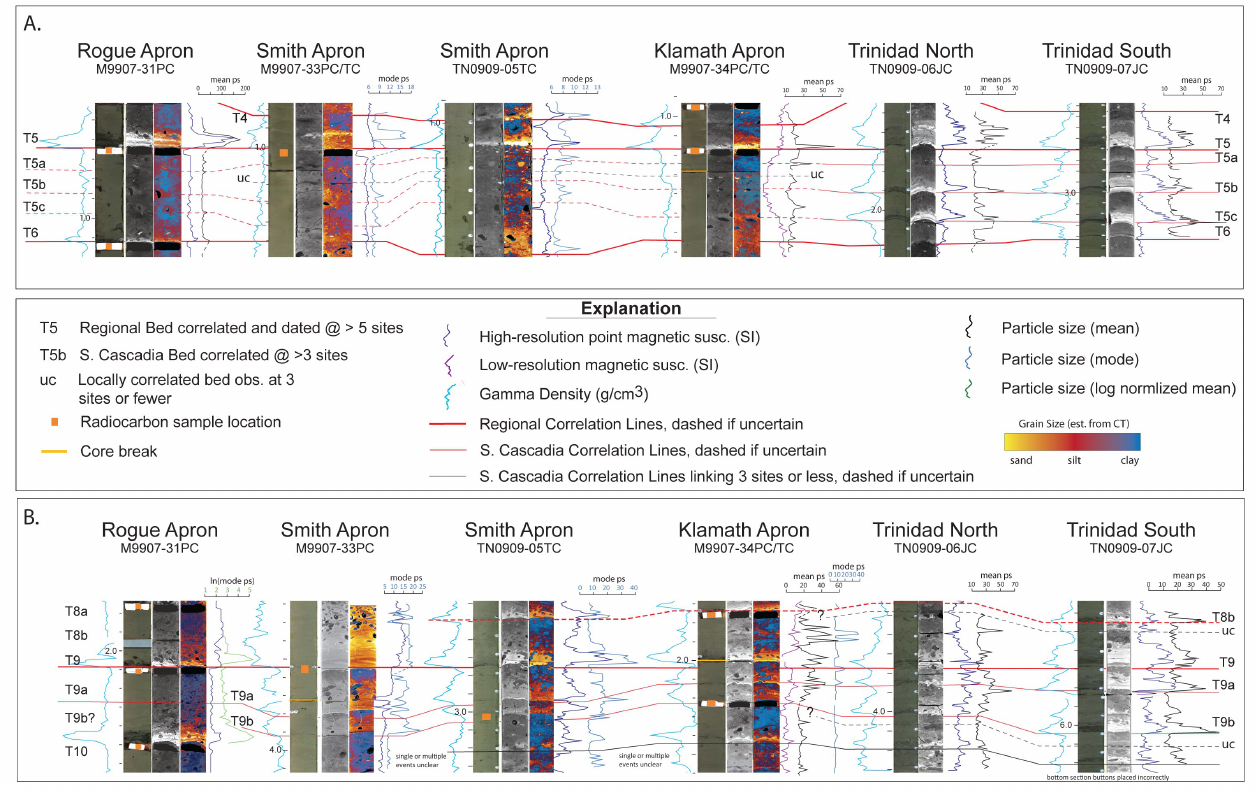
Fig. 7. (A) Detailed physical property and CT data from correlated events T5, T5a, T5b, and T5c in a transect from Rogue Apron to the Trinidad Plunge Pool, flattened to regional event T5. This transect shows the southward increase in thickness, density and grain size for regional event T5 and three southern Cascadia beds (T5a–c). (B) A similar transect for events interpreted as T9, T9a, and T9b. Examples are approximately flattened to correlated event T9, shown by heavy red line. These data are shown in context in Fig. 8. Mean grain size shown for cores with sandier turbidites and large contrast between turbidites and hemipelagic. Grain size mode shown for Smith and Klamath apron cores, which have poorly developed channel systems, and reduced average grain size profiles. Mean and mode shown for 34PC for comparison. In these cores, the grain-size variation is commonly dominated by large biogenic forms. Log-transformed grain size data shown in green for 31 PC, which has the finest grain size profile for the Rogue mud turbidites. See Fig. 1 for core locations. Age control, and density and magnetic scales shown in Fig.